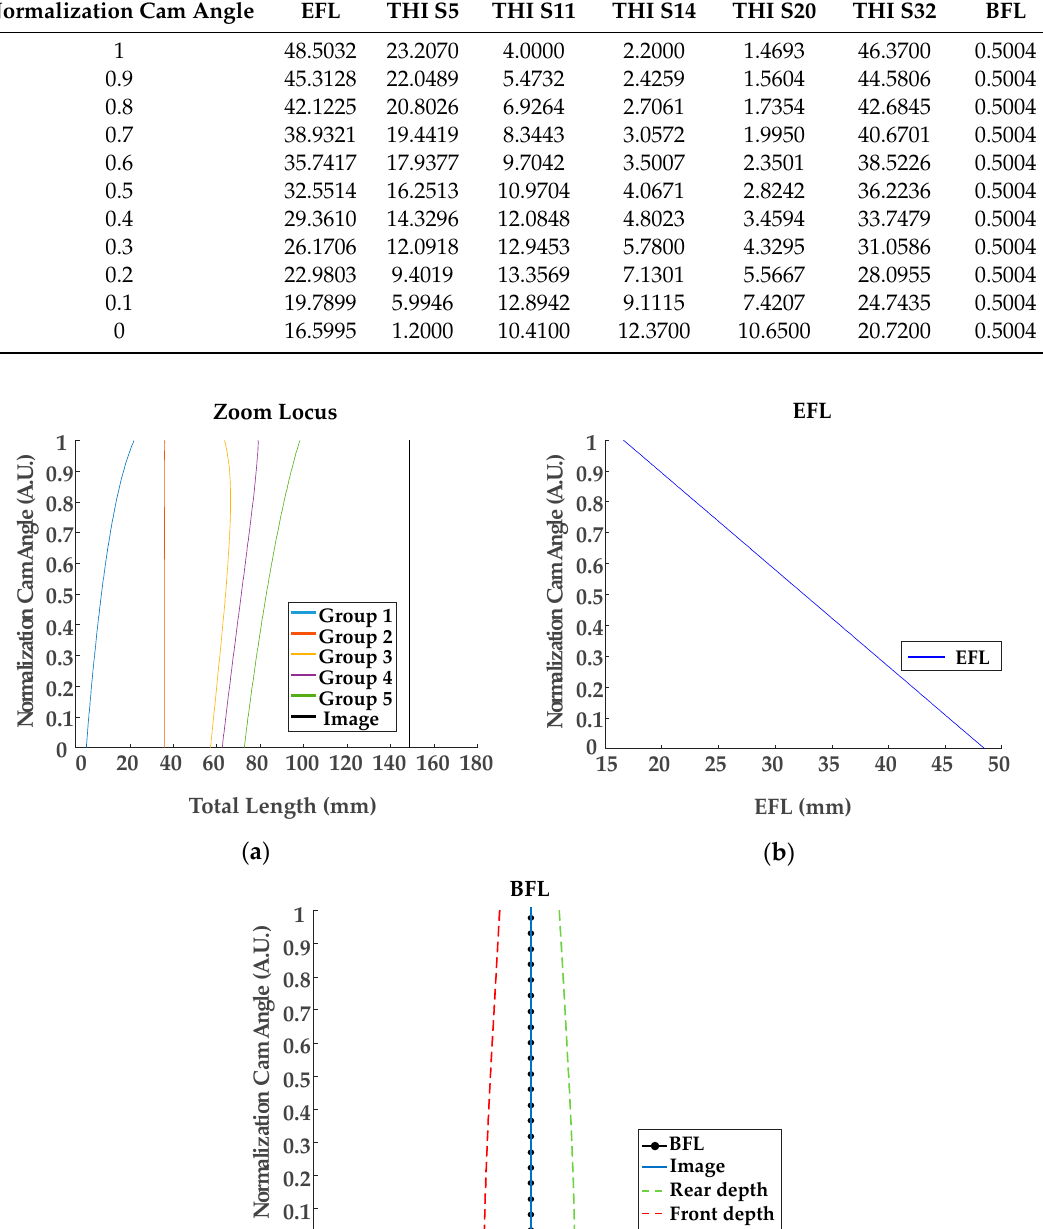
Table 6. Result of correcting the error for the image plane and EFL by moving the first and fourth lens groups.